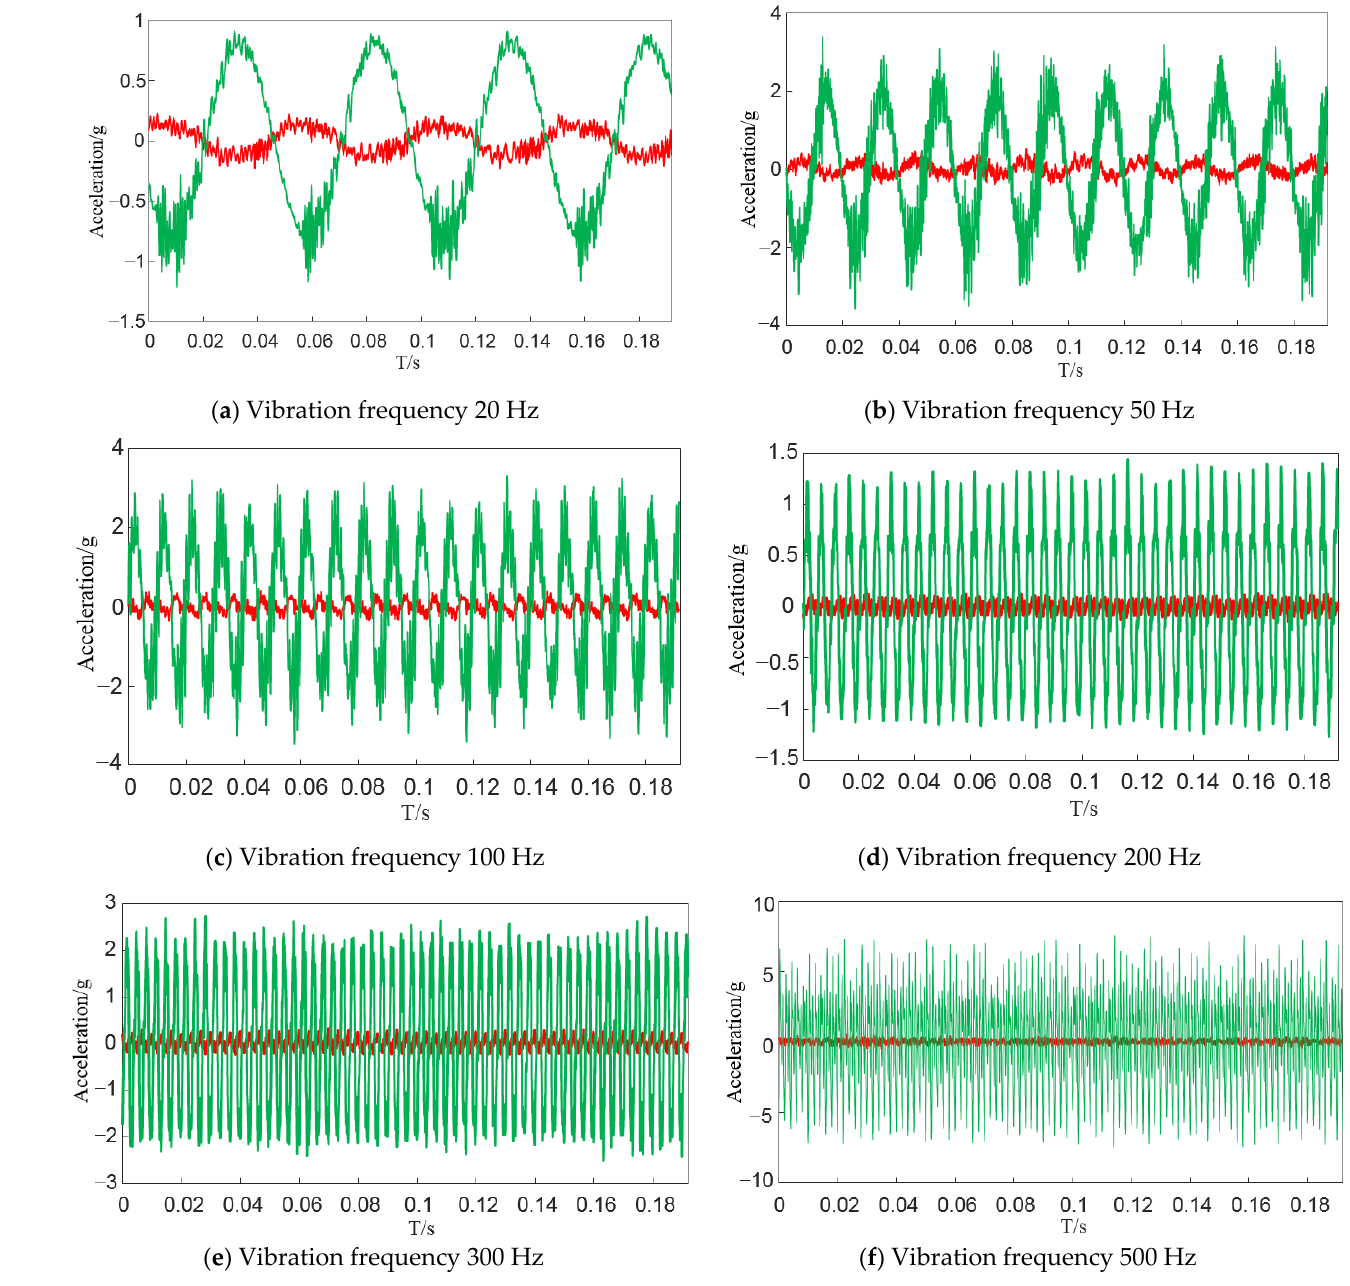
Figure 15. Vibration isolation effect of PECVIS.